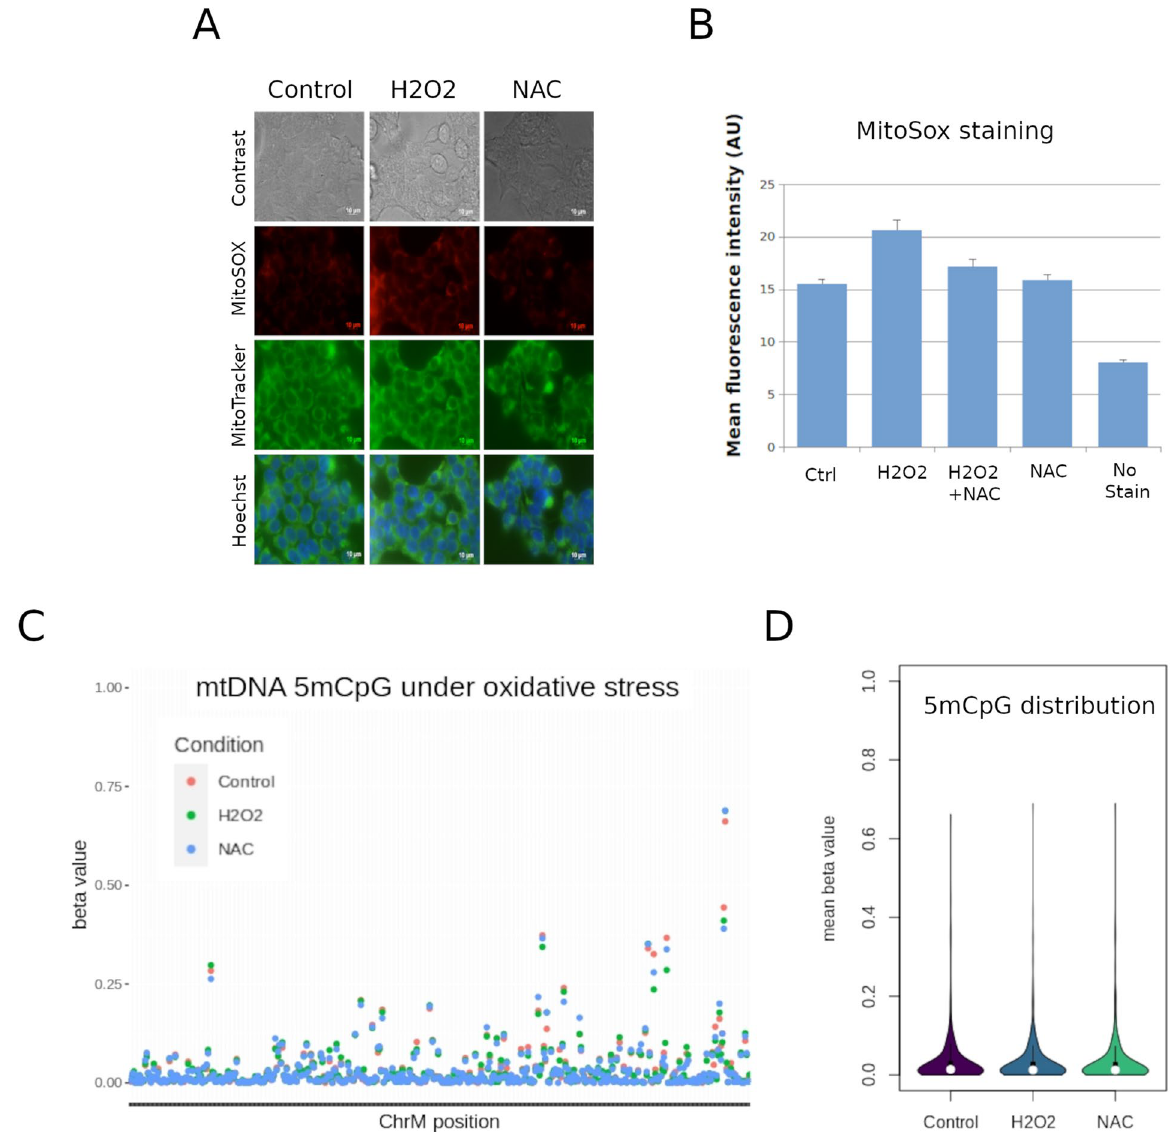
Figure 4. Mitochondrial 5mCpG in response to oxidative stress. Mitochondrial DNA was obtained from the human embryonic kidney cell line 293 T under basal conditions (Control), oxidative stress (H2O2) and oxidative stress rescued with N-acetlycysteine (NAC). ( A ) Representative images of phase contrast, Mitosox, MitoTracker and Hoescht staining. ( B ) MitoSox quantification of 5 independent replicates. ( C ) 5mCpG measured by nanopore under the same experimental conditions. Each dot represents the average of triplicate values for each condition and each CpG site. ( D ) Mitochondrial 5mCpG distribution (both, HS and LS strands together) of the data shown in ( C